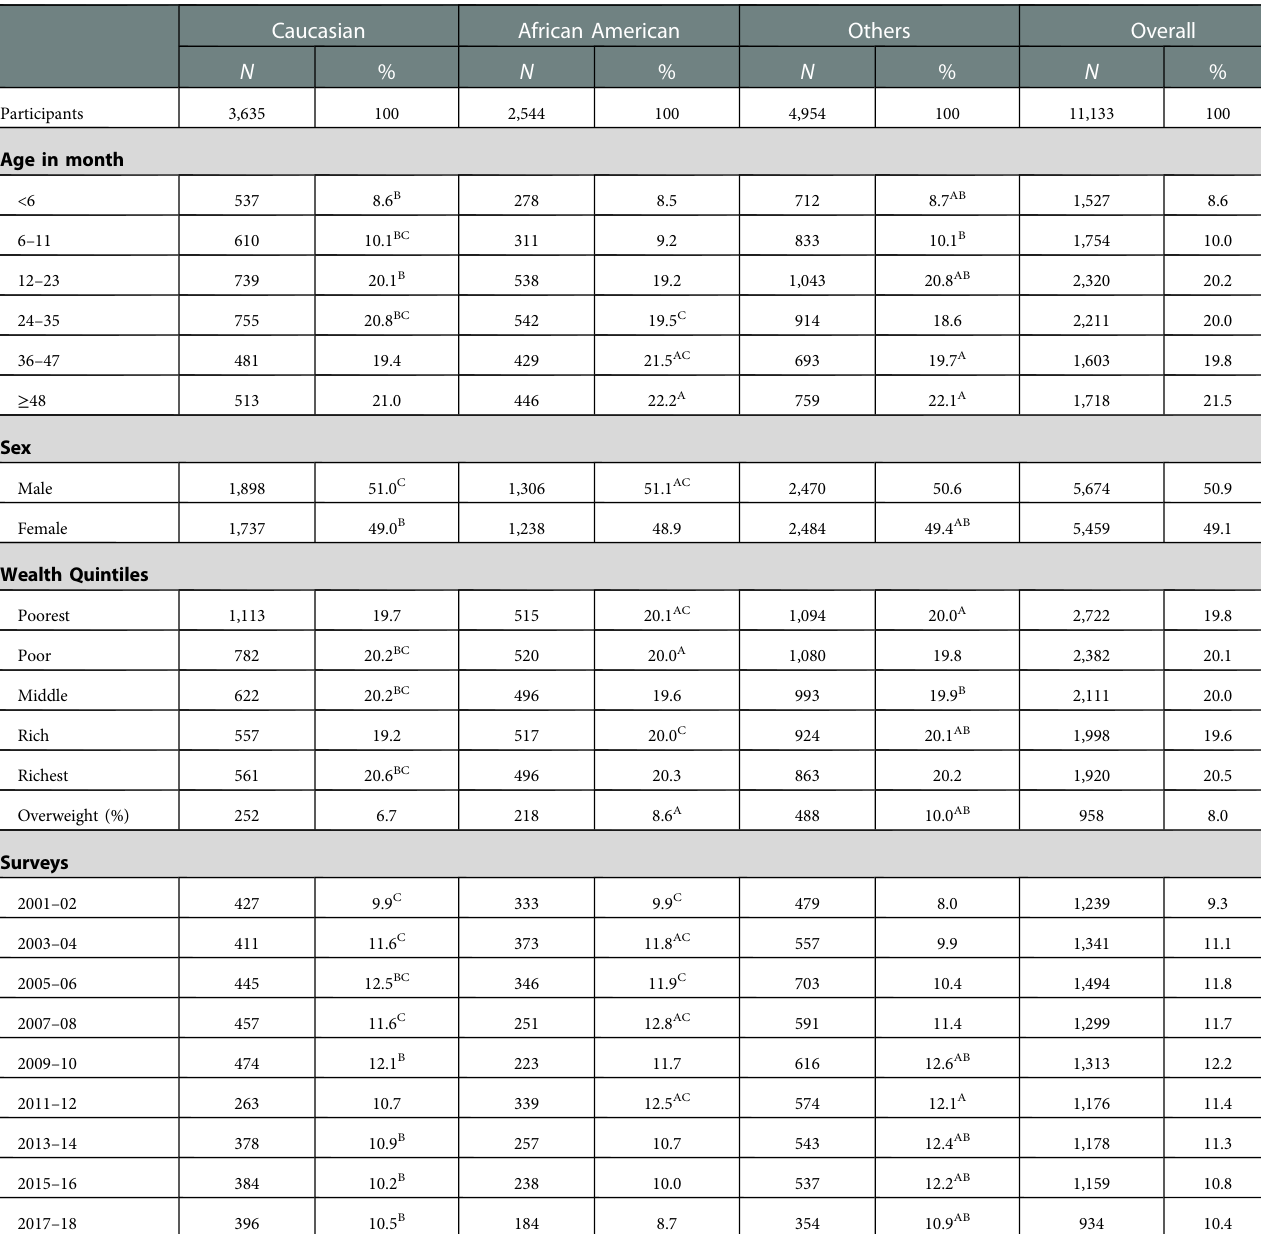
TABLE 1 Sociodemographic characteristics of children under fi ve years of age by ethnicity, NHANES 2001 – 2018. Caucasian African American Others